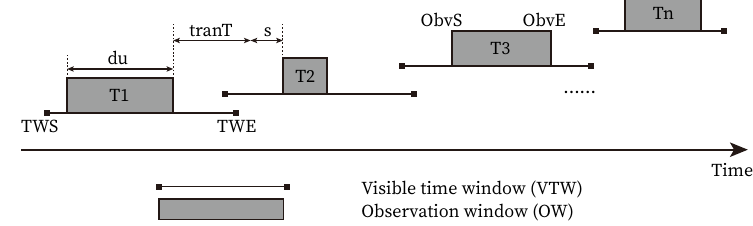
Figure 3. Description of the observation task scheduling